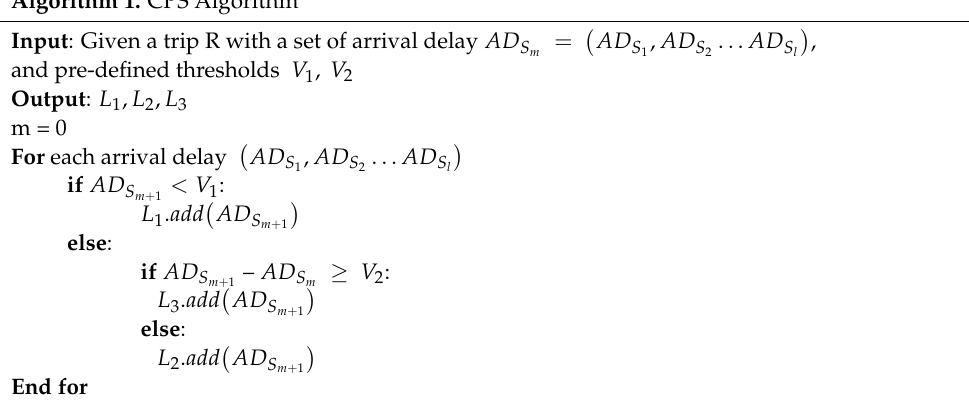
Algorithm 1. CPS Algorithm